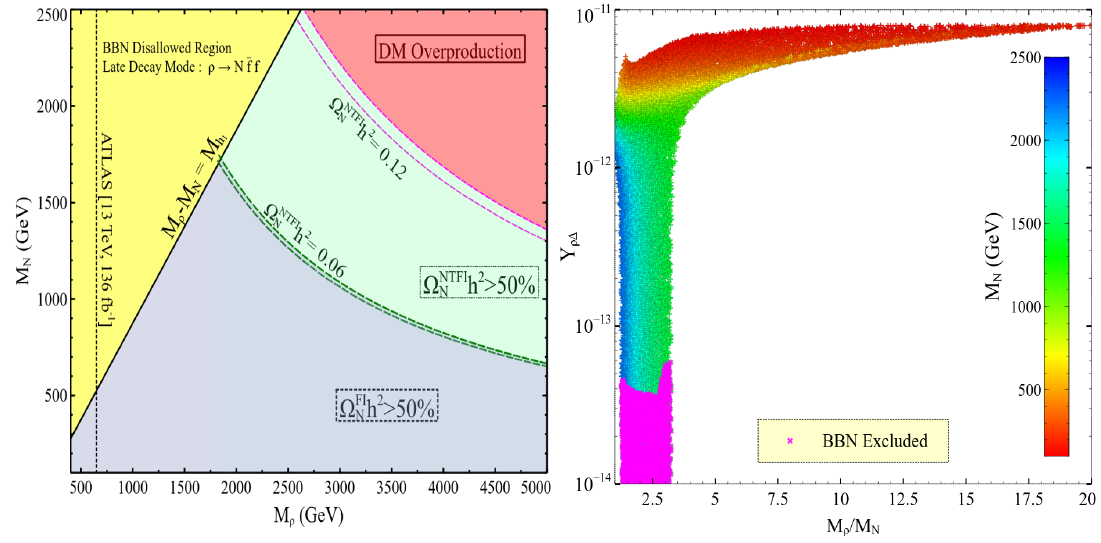
Figure 17 . Left panel: contour plot showing Ω FI h 2 > 50% and Ω NTFI h 2 > 50% in the M ρ - M N N N plane. The decay ρ → NH remains open in the region where M , as we consider 1 ρ − M N > M H 1 that ρ is not a stable particle. In the yellow region, ρ → Nf ¯ f contributes to Ω NTFI h 2 which takes N place approximately around 10 3 - 10 5 sec and is thereby disallowed by BBN. Right panel: scatter plot in the Y - M plane where the magenta points are disallowed by the BBN constraint ρ /M N ρ ∆ on light elements [32,